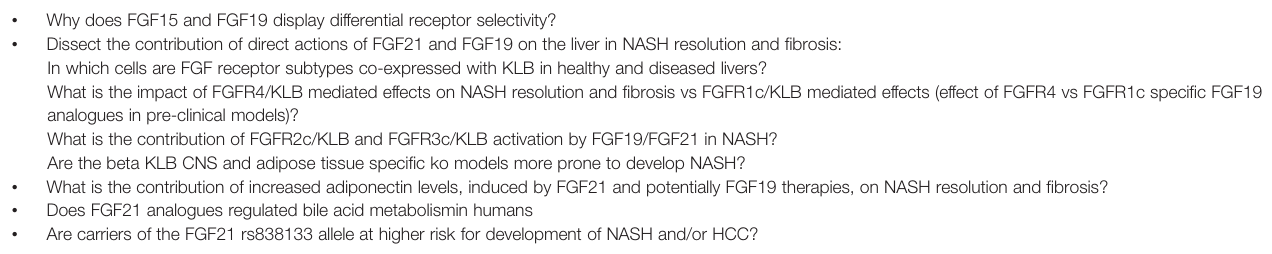
TABLE 3 | Future research questions for FGF19 and FGF21 with the NASH fi